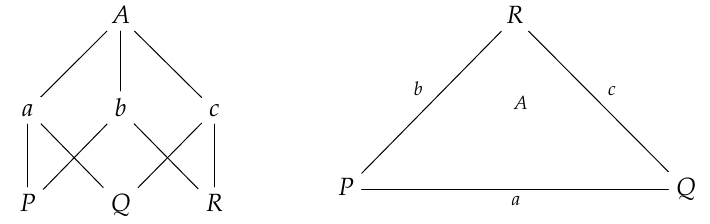
Figure 1. ( Left ): The Hasse diagram of the face poset of the triangle on the ( right ).